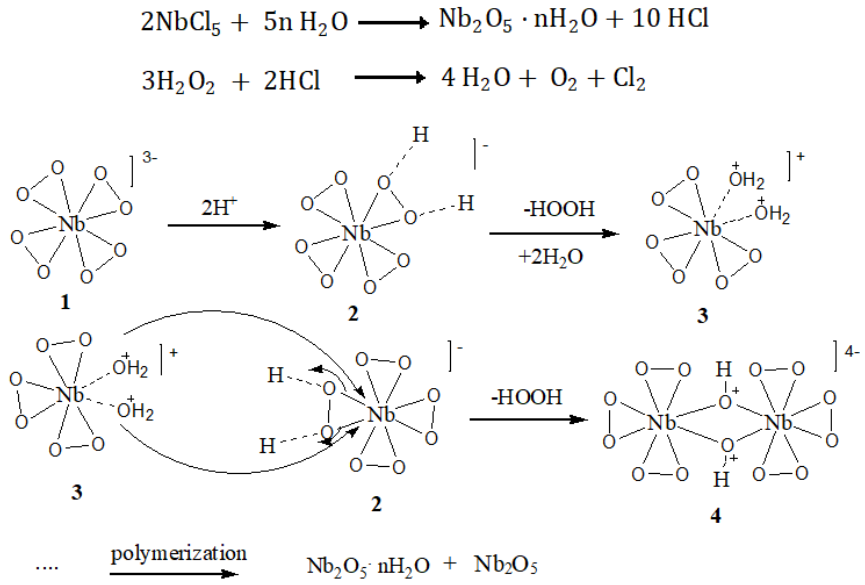
Figure 2. The proposed reaction mechanism for Nb 2 O 5 formation.